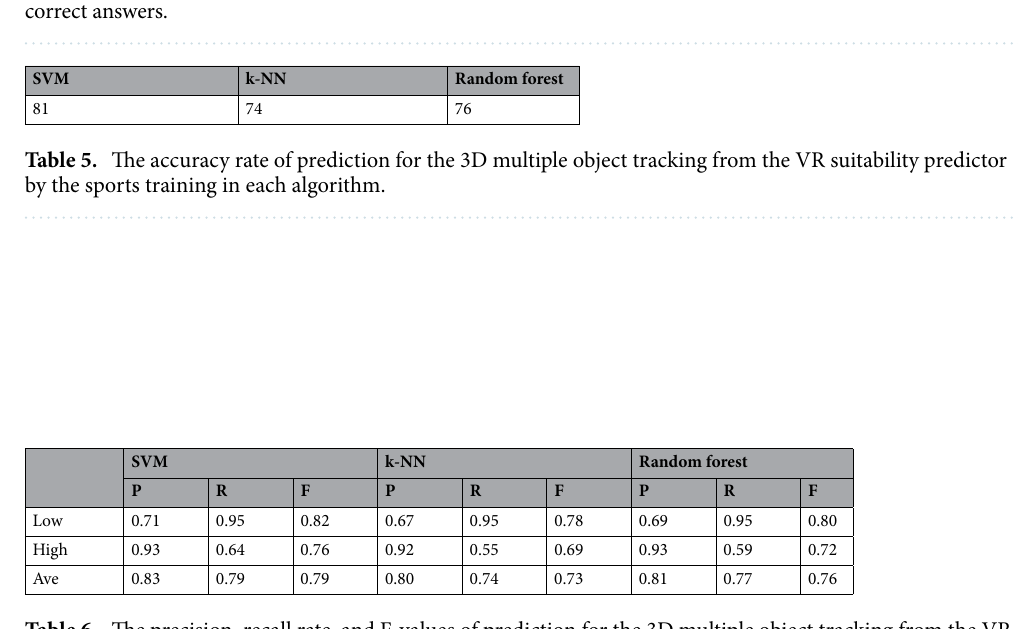
Table 6. The precision, recall rate, and F-values of prediction for the 3D multiple object tracking from the VR suitability predictor by the sports training in each algorithm. P precision, R recall rate, F F value.